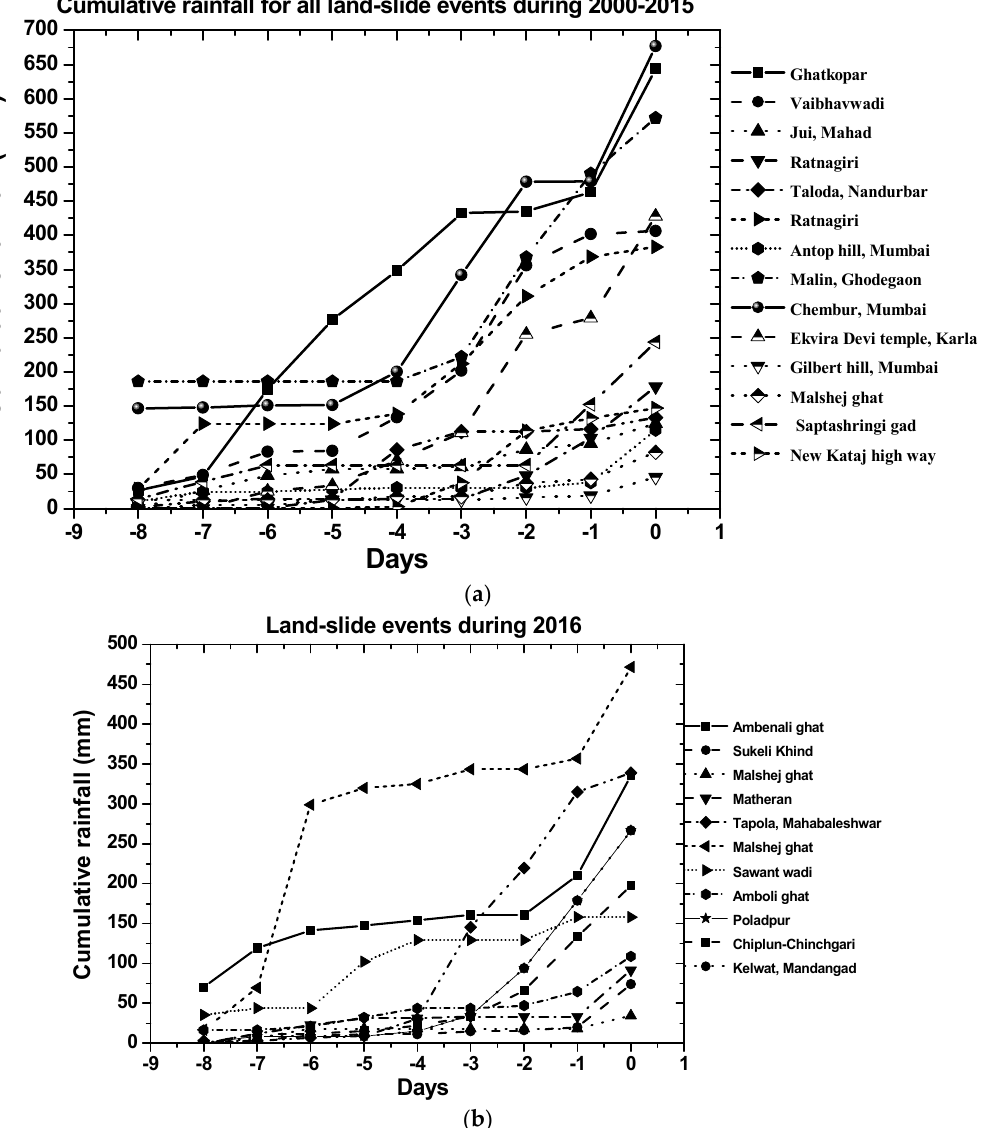
Figure 5. ( a ): Daily rainfall 8 days prior to LS occurrence and cumulative rainfalls at 14 selected stations during the period 2000–2015. ( b ): Daily rainfall 8 days prior to LS occurrence and cumulative rainfalls at 11 selected stations in year the 2016.